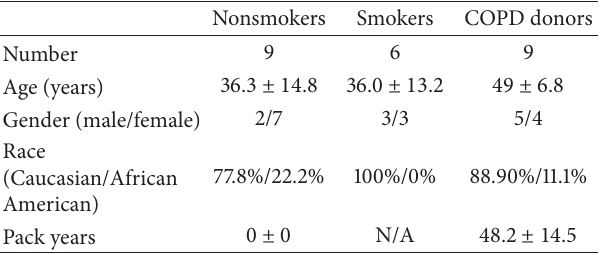
Table 1: Donor demographics for epithelial